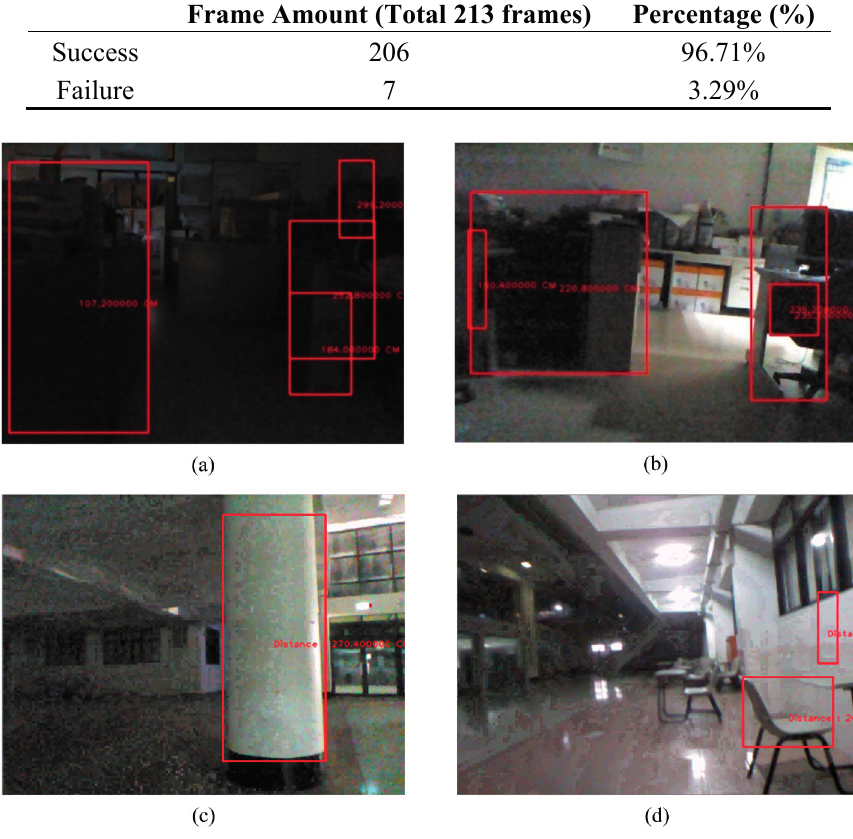
Figure 22. The detection of an indoor obstacle under insufficient light. ( a ) Laboratory 1; ( b ) Laboratory 2; ( c ) Lobby; ( d ) Corridor.